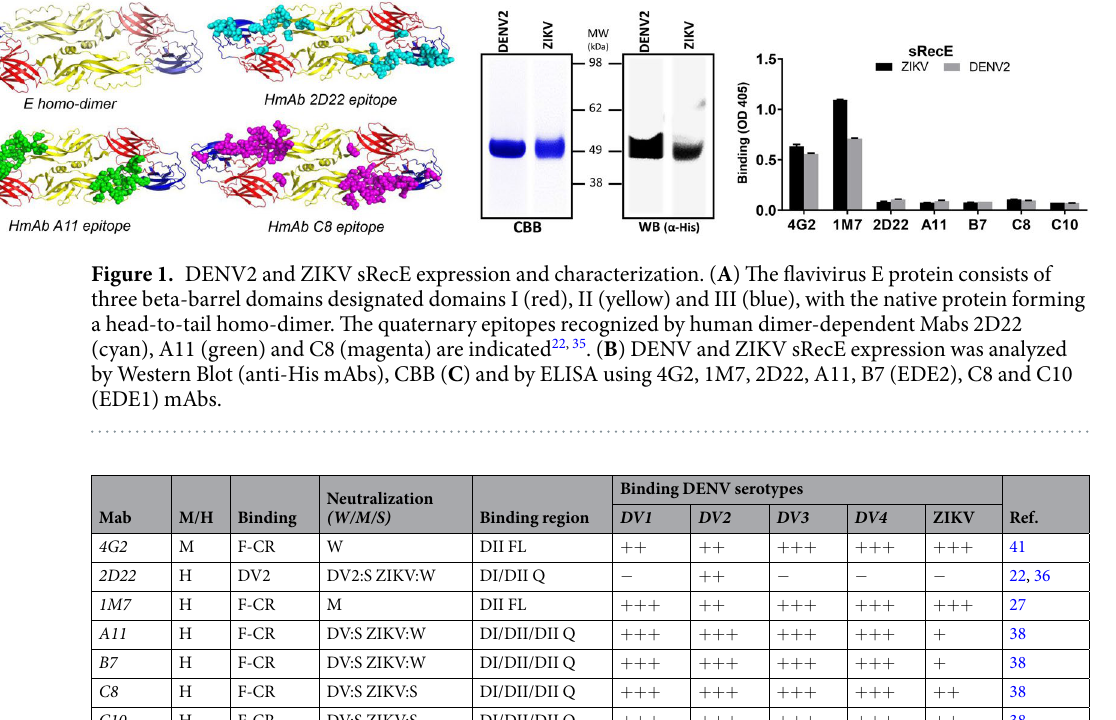
Table 1. Binding characteristics of used mAbs. Characteristics of the mAbs used for dimer assembly. Several mouse or human (M/H) derived mAbs were used for sRecE dimer assembly, indicating their DENV and ZIKV binding potential. Flavivirus cross reactive (F-CR), weakly, medium or strong (W/M/S) neutralizing, E-domain I, II, III (DI, DII, DIII), fusion loop (FL), quaternary epitope